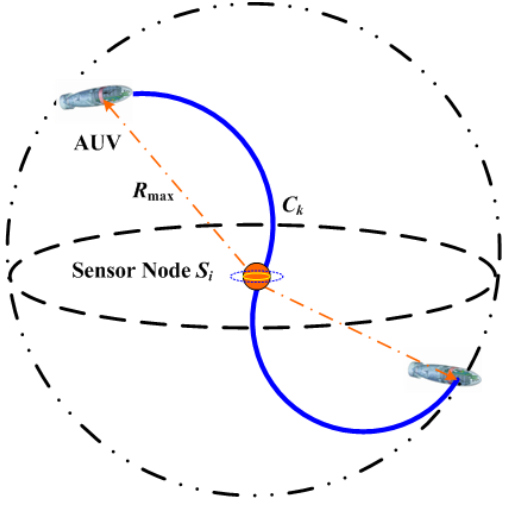
Figure 7. Data gathering at sensor node S i